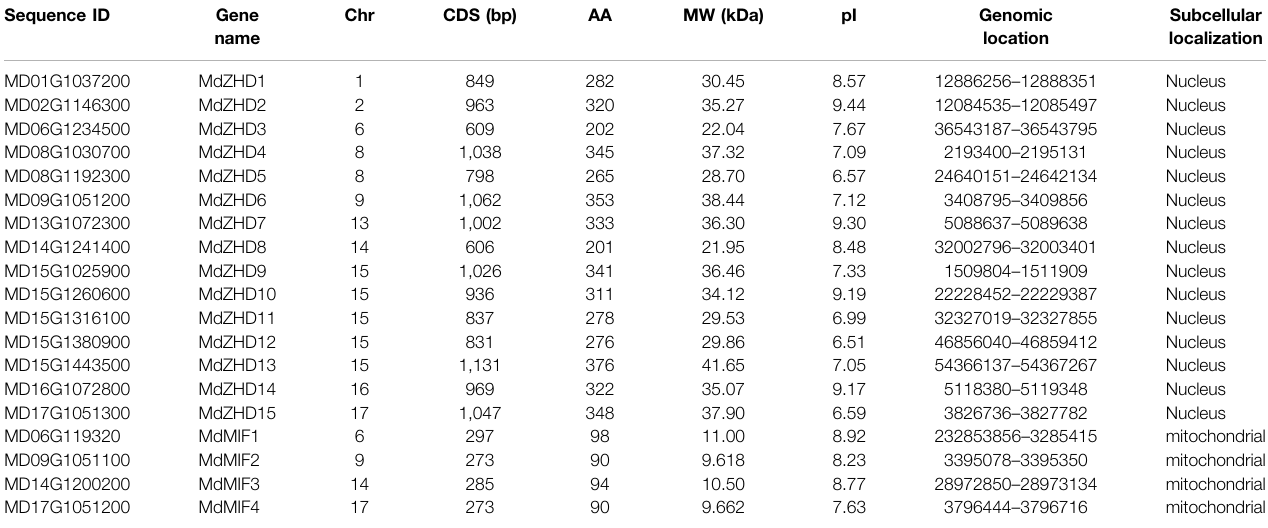
TABLE 1 | Characteristics of ZF-HD gene identi fi ed in apple. Sequence